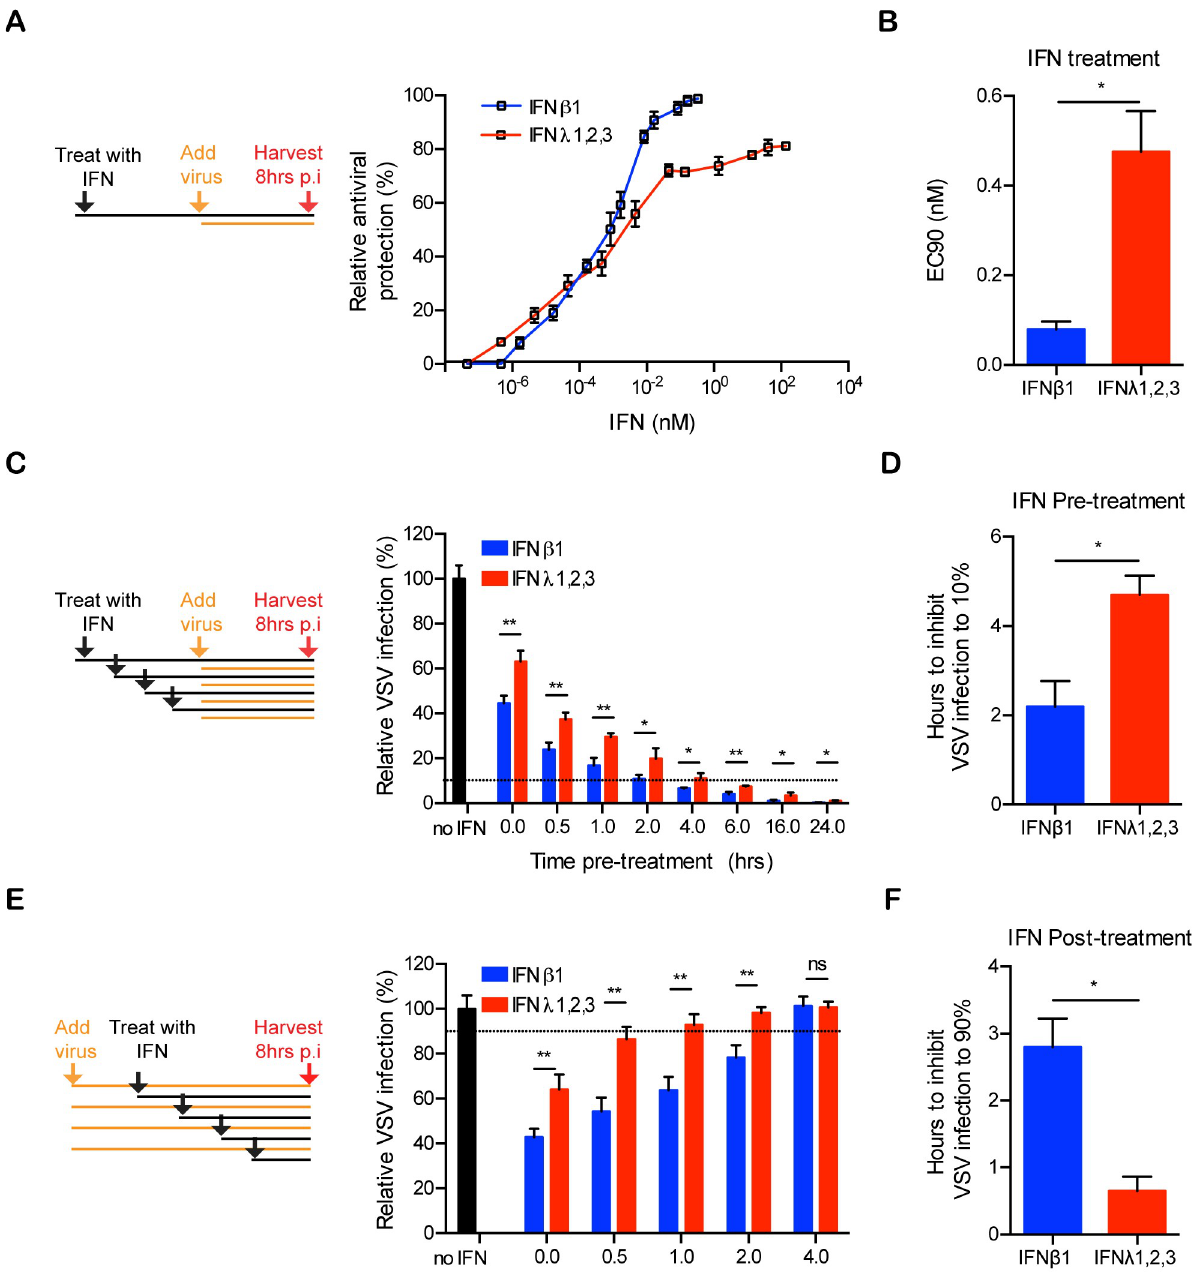
Fig 1. Kinetics of type I and type III IFN-mediated antiviral activities in human mini gut-organoids. (A-B) Colon organoids were pre-treated with the indicated concentrations of type I IFN ( β ) or type III IFN ( λ 1 − 3) for 2.5 h prior to infection with vesicular stomatitis virus (VSV) expressing Firefly luciferase (VSV-Luc) using a multiplicity of infection (MOI) of 1. Viral replication was assayed by measuring the luciferase activity. (A) The relative antiviral protection is expressed as a percentage of total protection in VSV-infected organoids or (B) as the EC90 corresponding to the concentration of type I IFN ( β ) or type III IFN ( λ 1 − 3) resulting in 90% inhibition (10% infection) of viral replication. (C-D) Colon organoids were treated with type I IFN ( β ) (2,000 RU/mL equivalent 0.33 nM) or type III IFN ( λ 1 − 3) (100ng/mL each or total 300 ng/mL equivalent 13.7 nM) for different times prior to infection with VSV-Luc. Viral replication was assayed by measuring luciferase activity. (C) The relative VSV infection is expressed as the percentage of the luciferase activity present in VSV-infected organoids without IFN treatment (set to 100). (D) Pre-incubation time of type I IFN ( β ) or type III IFN ( λ 1 − 3) required to inhibit VSV infection to 10% (90% inhibition). (E-F) Same as (C-D), except colon organoids were treated at the indicated times post-infection with VSV-Luc. (F) Delayed-time post-infection for type I IFN ( β ) or type III IFN ( λ 1 − 3) to still inhibit VSV infection to 90% (10% inhibition). Data in (A–F) represent the mean values of two independent experiments. Error bars indicate the SD. � < P.05, �� P < 0.01, ns, not significant (unpaired t-test).